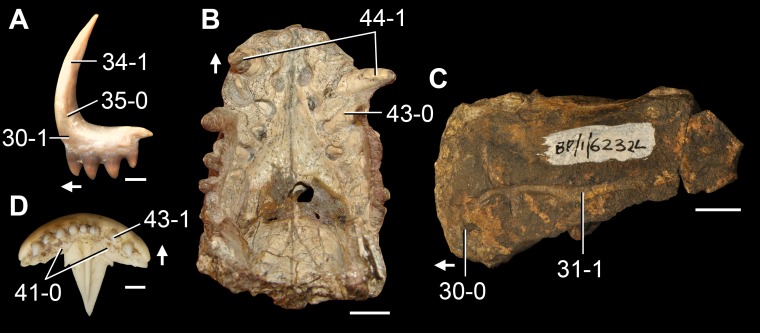
Left (A, C) and both (B, D) premaxillae of Triassic and Recent saurians in (A, C) lateral and (B, D) ventral views.(A) Planocephalosaurus robinsonae (NHMUK PV R9955); (B) Proterosuchus goweri (NMQR 880); (C) Garjainia madiba (BP/1/6232L; and (D) Salvator merianae (MACN-He 47992). Numbers indicate character-states scored in the data matrix and the arrows indicate anterior direction. Scale bars equal 0.5 mm in (A), 2 cm in (B), 1 cm in (C), and 2 mm in (D).